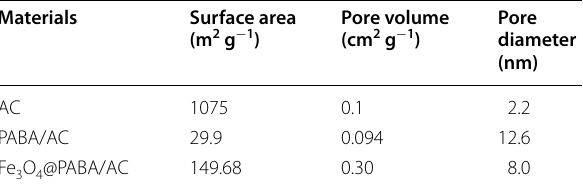
Table 2 Surface properties of the as-synthesized materials obtained by BET analysis Materials